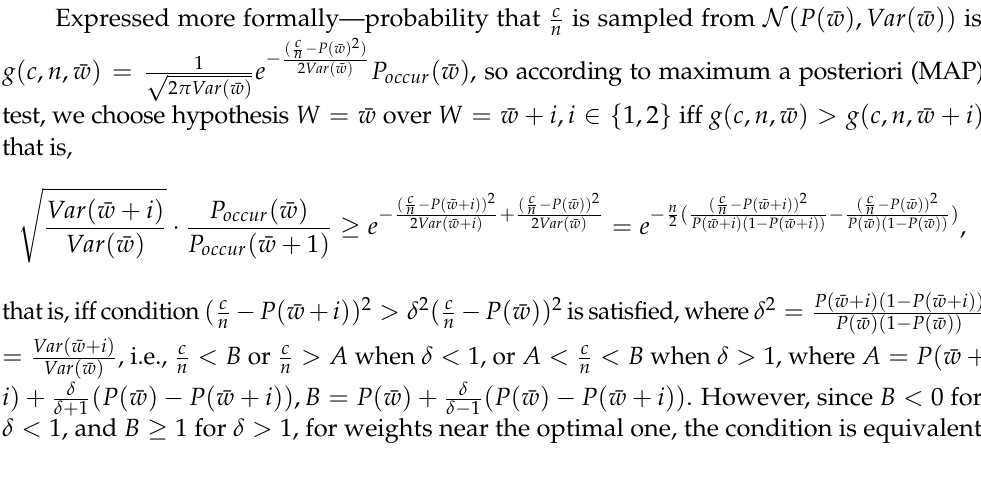
Figure 9. PB-decision zones used after eavesdropping ( left ) and for bit recovery ( right